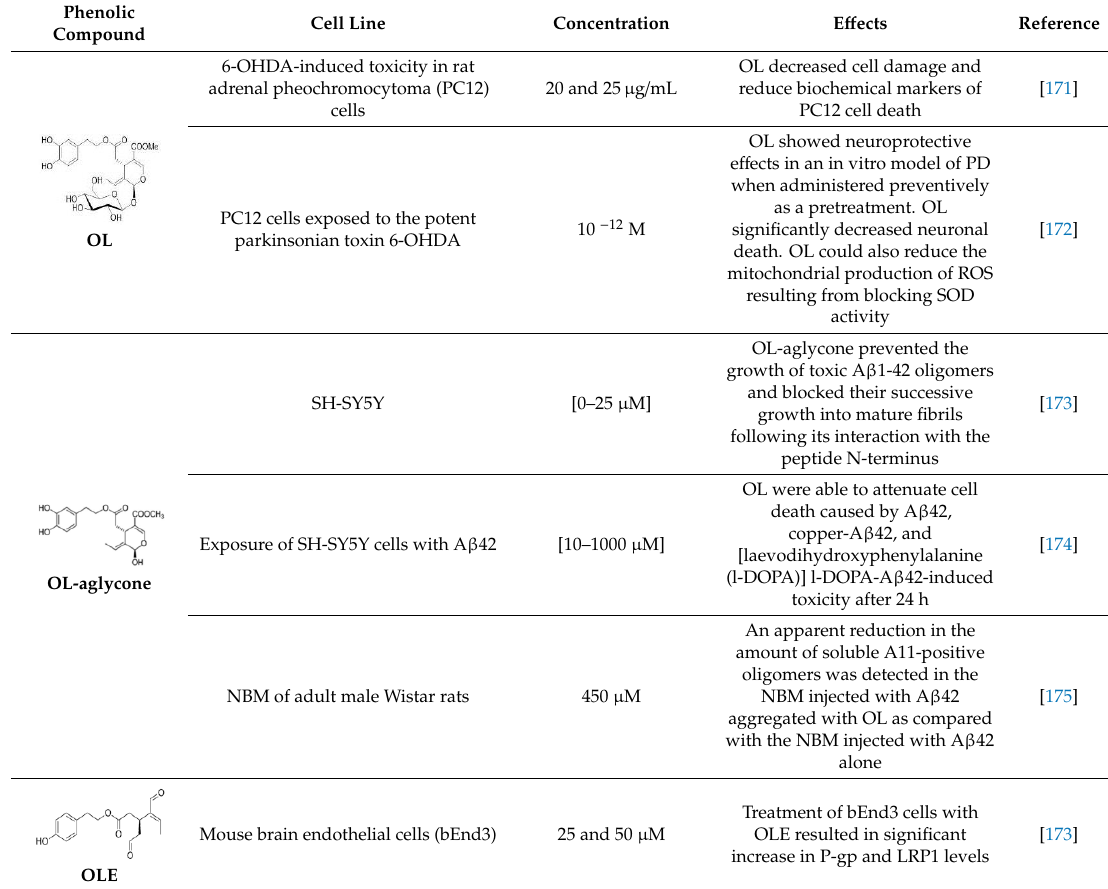
Table 6. In vivo studies that corroborate the effects of secoiridoids from the olive tree in different Phenolic